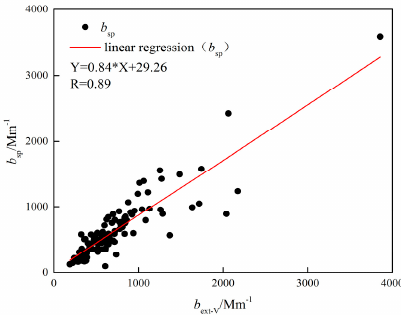
Figure 5. Comparison of the IMPROVE-calculated light scattering by particles versus that retrieved from visibility measurements.